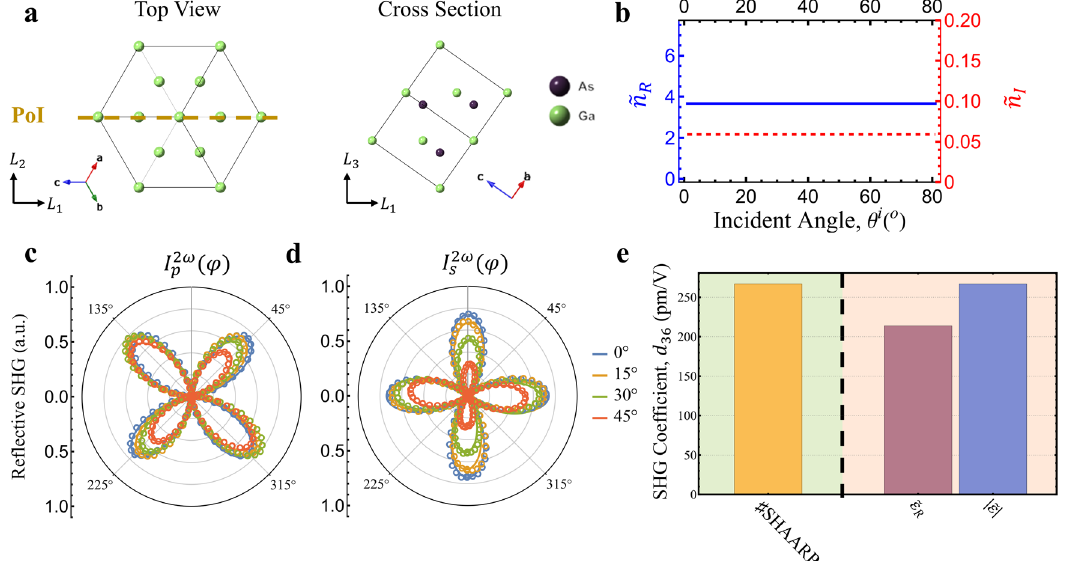
Fig. 4 Linear and nonlinear optical responses of GaAs (111). a Crystal structure and experimental orientation. The L 1 ; L 2 ; L 3 ð Þ and a ; b ; c ð Þ are the lab coordinate system and crystallographic coordinate system respectively. The dashed dark yellow line represents the projection of the plane of incidence to the L 1 (cid:2) L 2 plane. b The effective complex refractive indices at ω frequency as a function of incident angle ( θ i ), subscript R and I represent real and imaginary respectively. c and d p - and s -polarized second harmonic responses as a function of azimuthal angle ( φ ) at various incident angles ( θ i ). The open circles are experimental results, and the solid lines are theoretical fi ts. e Comparison of the SHG coef fi cients with no approximations (labeled as ♯ SHAARP, pale green background) as against those extracted with various approximations (pale orange background). ~ ε R , and ~ ε j j represent the real component of ~ ε , and the magnitude of the complex ~ ε ,